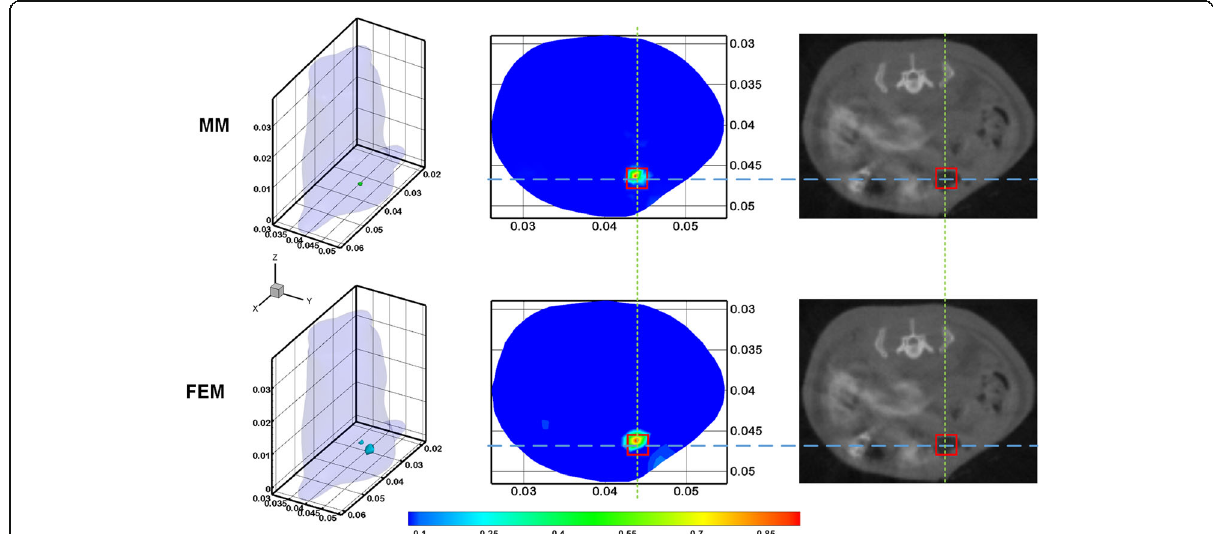
Fig. 1 Reconstruction of the in vivo experiment based on meshless method (MM) and finite element method (FEM). The first row and second row list the results of MM and FEM, respectively. The first and second columns list the 3-D visualization and cross-sectional of the reconstructed fluorescent sources. The third column lists the corresponding micro-CT cross-sectional image. The red square markers clarify the actual locations of the fluorescent bead. The figure is reproduced from